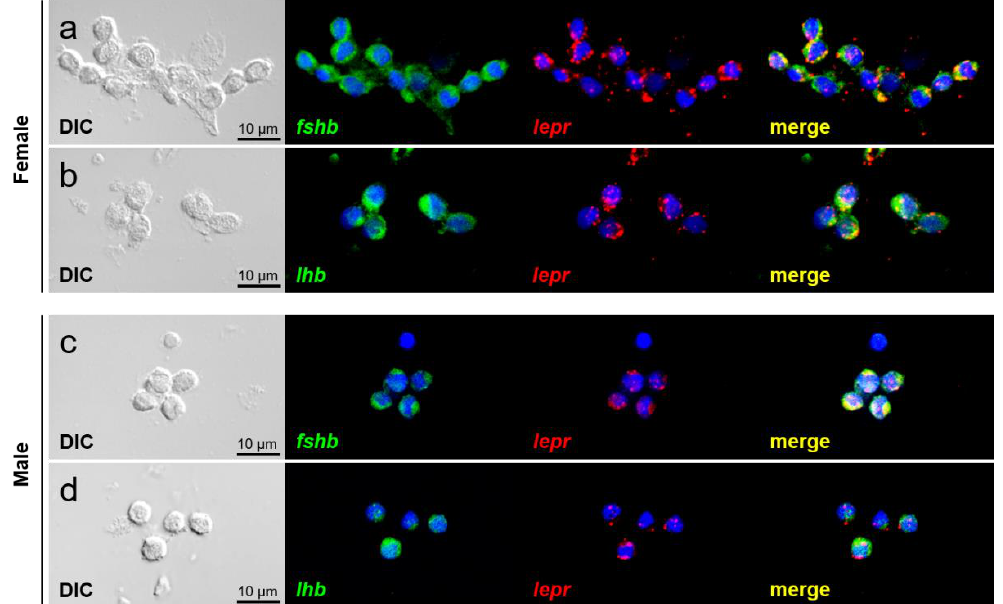
Figure 5. Double-label in situ hybridization in the primary cultured pituitary cells of females ( a , b ) and males ( c , d ). Cells were visualized by DIC image and DAPI staining of cell nuclei. Green fluorescence indicates fshb or lhb mRNA expression. Red fluorescence indicates lepr mRNA expression. Merged images show that FSH- and LH-producing cells co-expressing lepr mRNA. Scale bars = 10 μm.